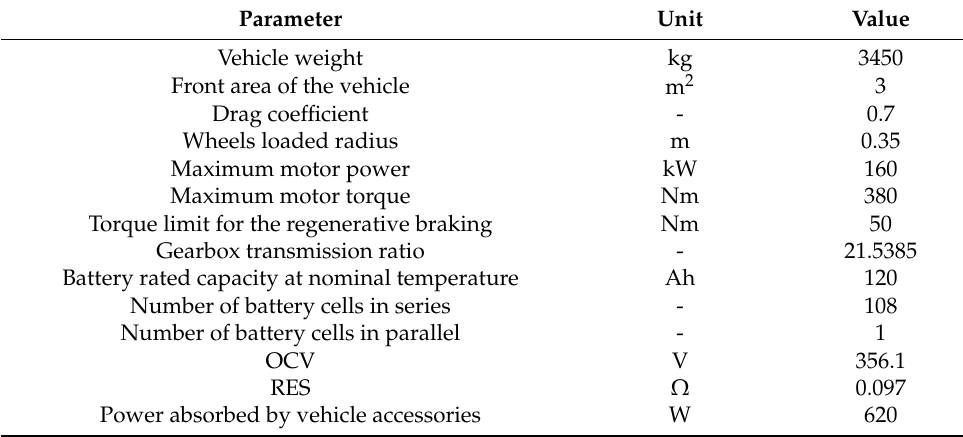
Table 1. Main data of the waste collection